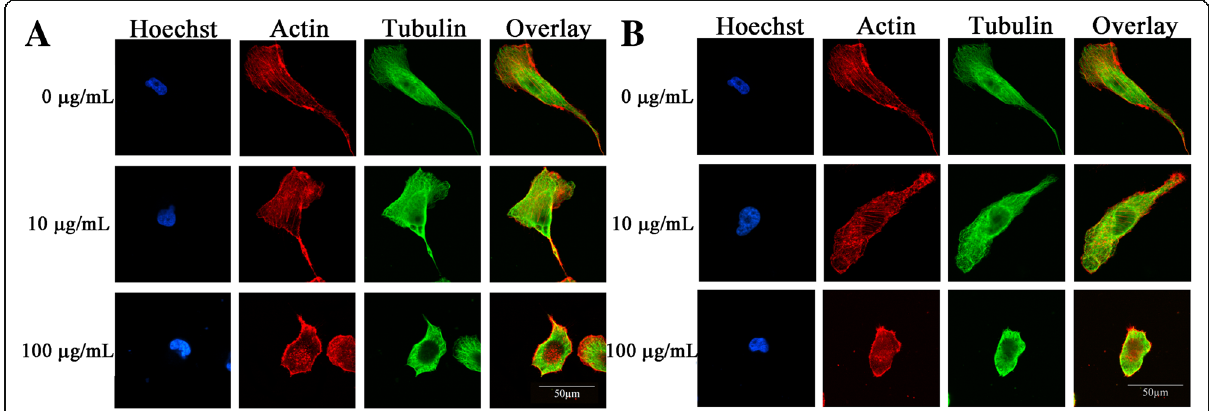
Fig. 6 TiO 2 and ZrO 2 NP-induced cytoskeleton changes in 3T3 cells. After the 3T3-E1 cells were treated with the TiO 2 ( a ) and ZrO 2 ( b ) NPs at concentrations of 10 and 100 μ g/mL for 24 h, the cytoskeleton changes were assessed based on the alterations of the actin (red) and tubulin systems (green)